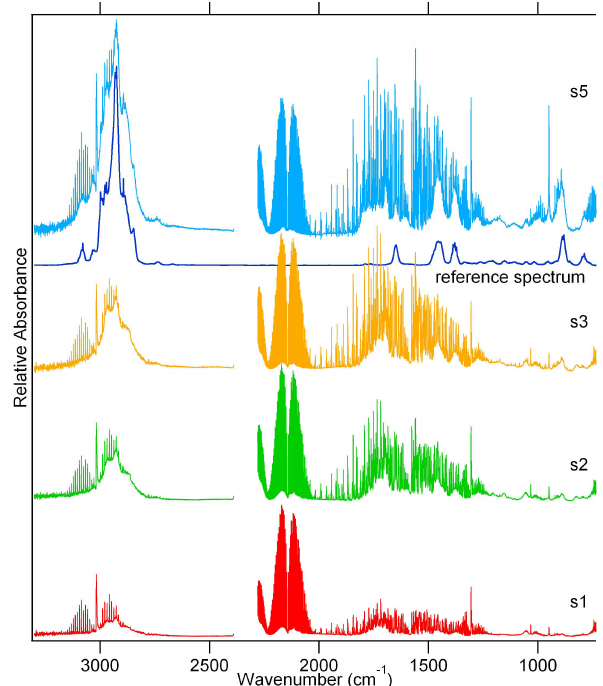
Fig. 4. Absorption spectra of ground samples normalized to the CO absorption band centered at 2143cm − 1 . Samples s1–s3 are of smoldering emissions from dead stumps while sample s5 is combus- tion occurring at the base of a living tree. The reference spectrum is a linear sum of three equal parts of the monoterpene species, α - pinene, β -pinene, and D-limonene spectra (Sharpe et al., 2004) and is shown only as a qualitative